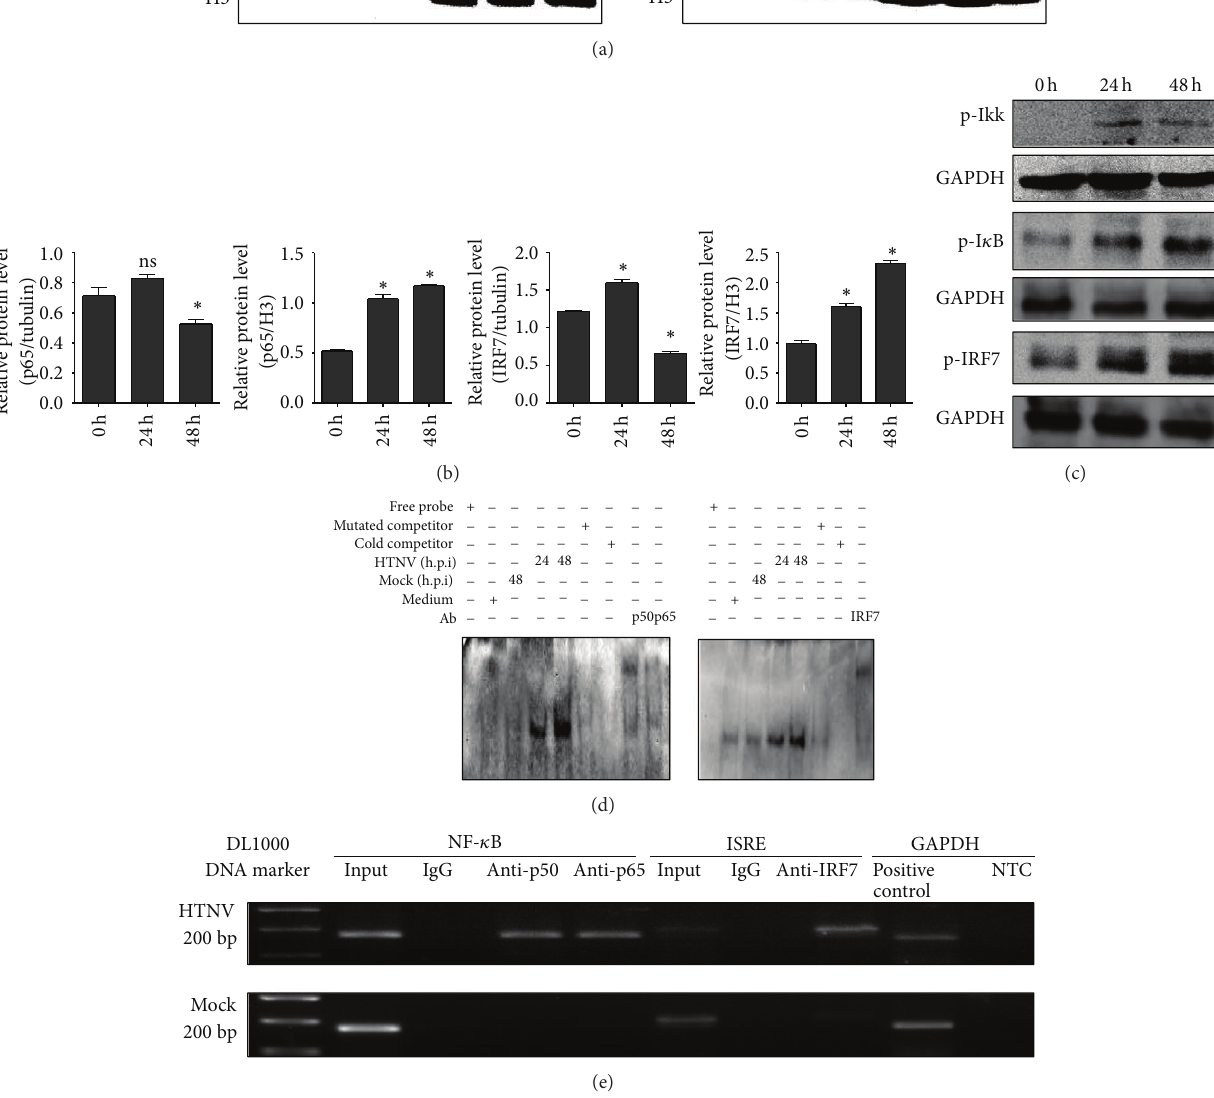
Figure 5: p65 and IRF7 translocate to nucleus and bind to CXCL10’s promoter after HTNV infection. (a) WB results showed that HTNV infection induced the nuclear translocation of p65 and IRF7. Lysates were also immunoblotted using anti- 𝛽 -tubulin or antihistone H3 (H3) as loading controls and to confirm the integrity of the cytosolic and nuclear lysates, respectively. (b) Semiquantitative analysis of p65 and IRF7 levels indicated in (a) was performed by Band-Scan software 5.0, and expression of 𝛽 -tubulin or H3 was used as cytosolic or nuclear control, respectively. Data were means ± SE. ∗ 𝑃 < 0.05 , 24 h or 48h versus 0 h p.i with HTNV. (c) At 24 h and 48h p.i, phosphorylation of Ikk, I 𝜅 B, and IRF7 can be detected by Western blot. (d) EMSA results showed direct bindings of p50 and p65 to the NF- 𝜅 B1 site (left) and IRF7 to the ISRE site (right) of CXCL10 promoter after HTNV infection. Super shift bands were shown when the specific antibodies to p50, p65, and IRF7 were used, respectively. (e) ChIP assay also documented that p50, p65, and IRF7 bound directly to the CXCL10 promoter. The upper panel showed that, at 48h post-HTNV infection, both a 177-bp DNA fragment and a 200-bp DNA fragment containing the NF- 𝜅 B1 site and ISRE site in the CXCL10 promoter, respectively, can be amplified successfully, while the mock virus cannot (lower panel). The input DNA and the positive (anti-polymerase antibody) and the negative control (normal mouse IgG) were used to verify the reliability of ChIP